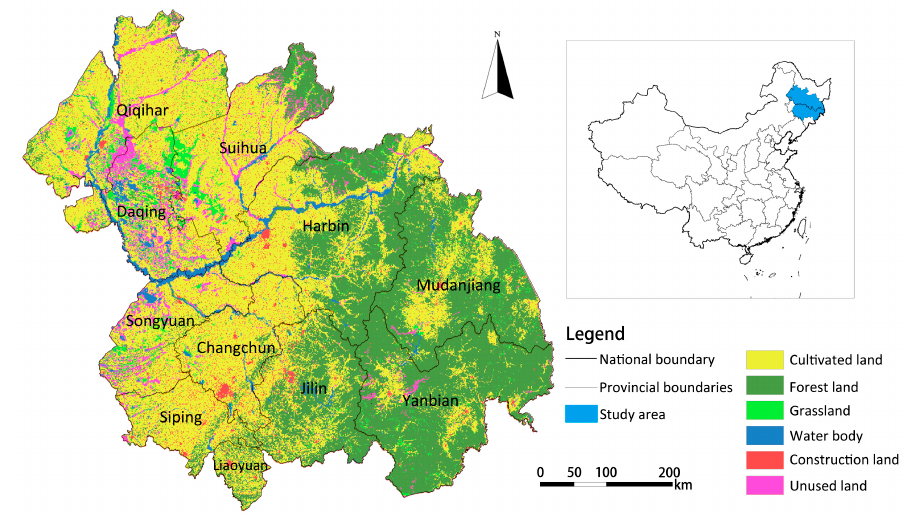
Figure 1. Land cover and geographical location of the Harbin-Changchun urban agglomeration.